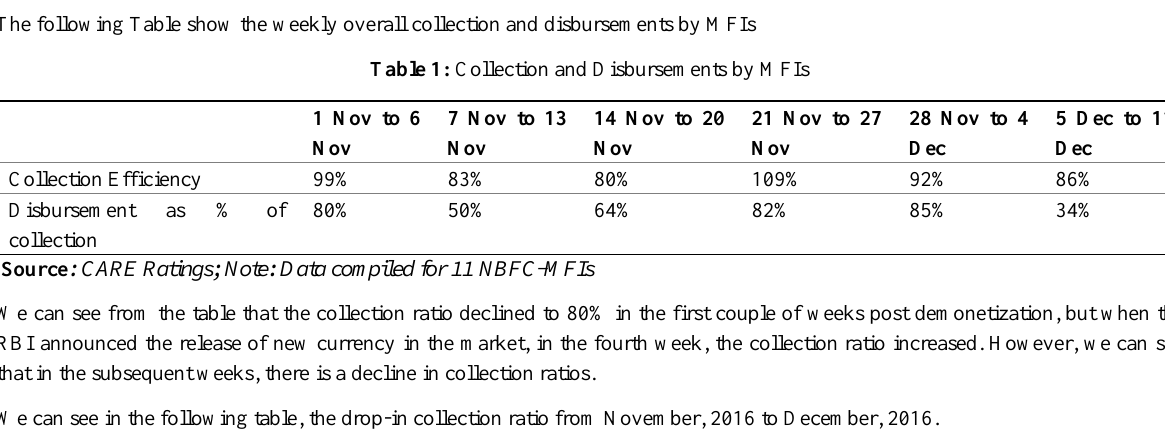
Table 2: Collection Efficiency of MFI,